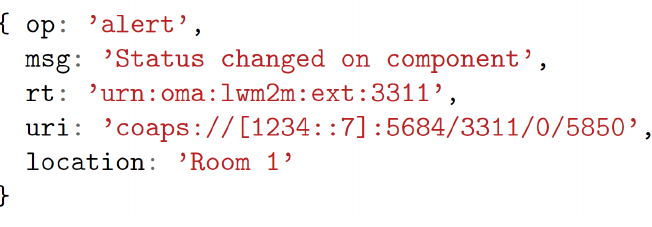
Figure 8. Alert message sent from the PoCo to an user